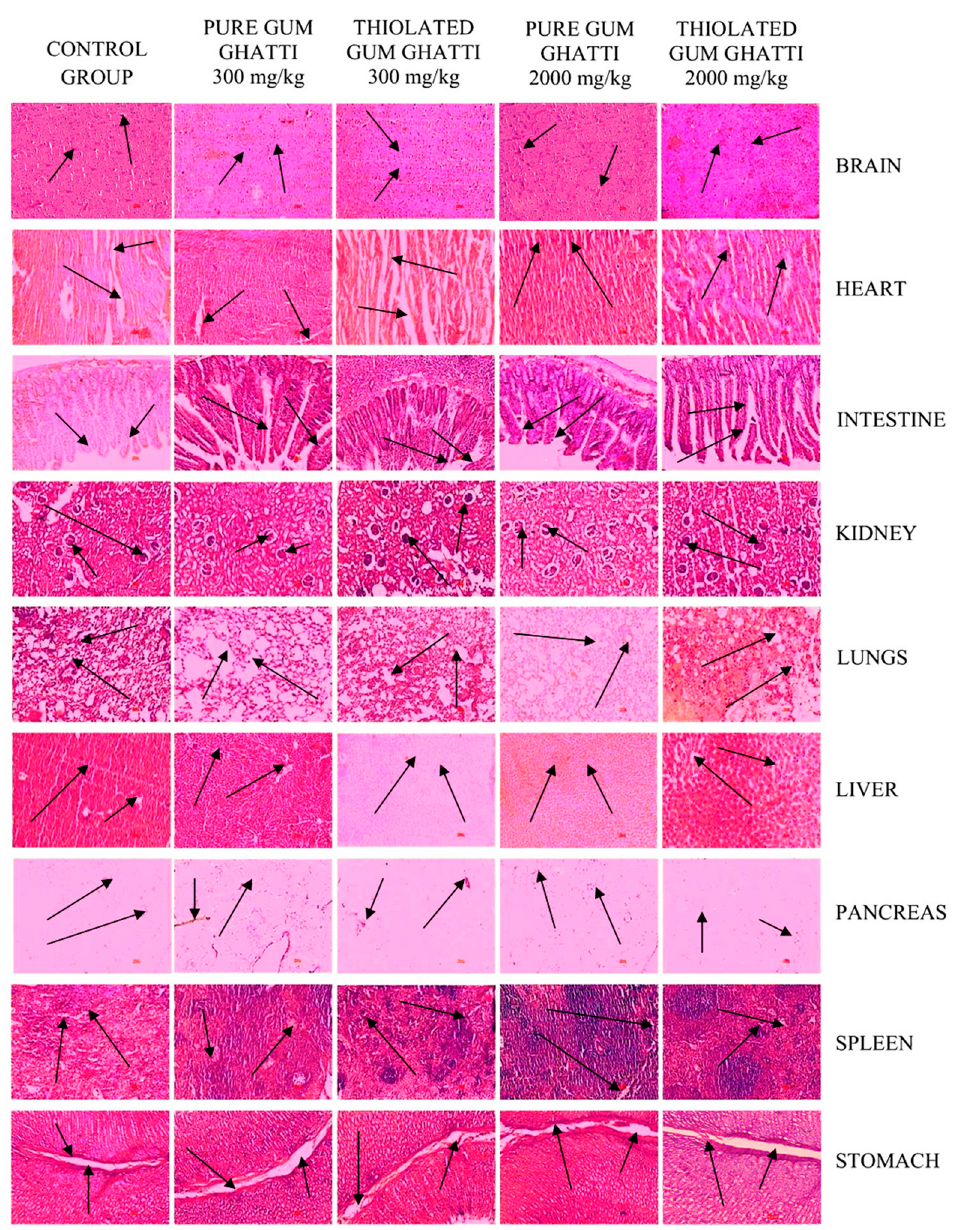
Figure 3. Photomicrographs of the histopathological examination of small, transverse portions of Wistar rat tissues, including the brain, heart, intestine, kidney, lungs, liver, pancreas, spleen, and stomach. Column 1: Control; Column 2: Pure gum ghatti (300 mg/kg body weight); Column 3: Thiolated gum ghatti (300 mg/kg body weight); Column 4: Pure gum ghatti (2000 mg/kg body weight); Column 5: Thiolated gum ghatti (2000 mg/kg body weight).